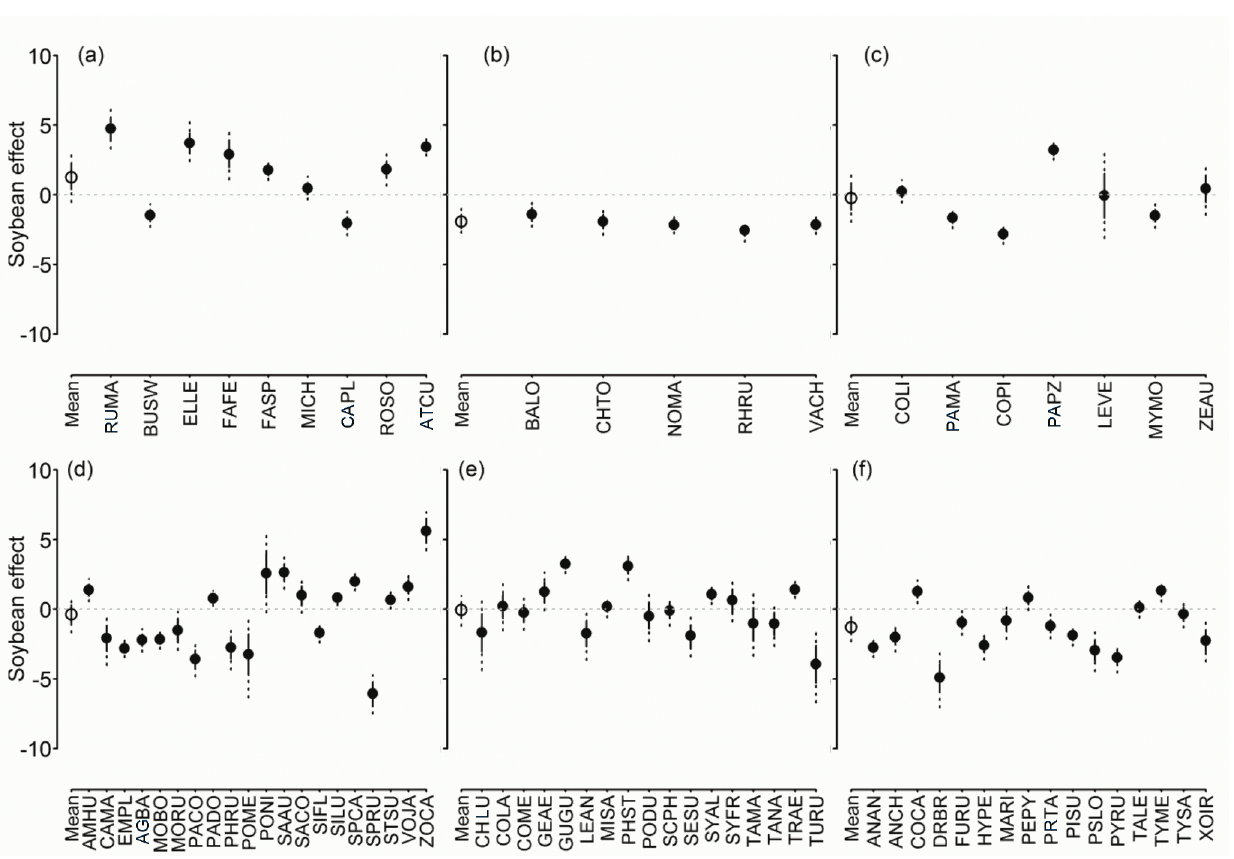
^ β ± Fig 6. Soybean coefficients in the logit scale ( SD, 95% BCI) on logit occupancy (logit ^ ψ ) of each bird species in the regional bird monitoring program in Argentina, 2003 – 2012. (a) Raptors; (b) ground omnivores and herbivores; (c) ground granivores; (d) other granivores; (e) insectivores mostly associated with folliage; (f) other insectivores. For details of species names and guilds, see S1